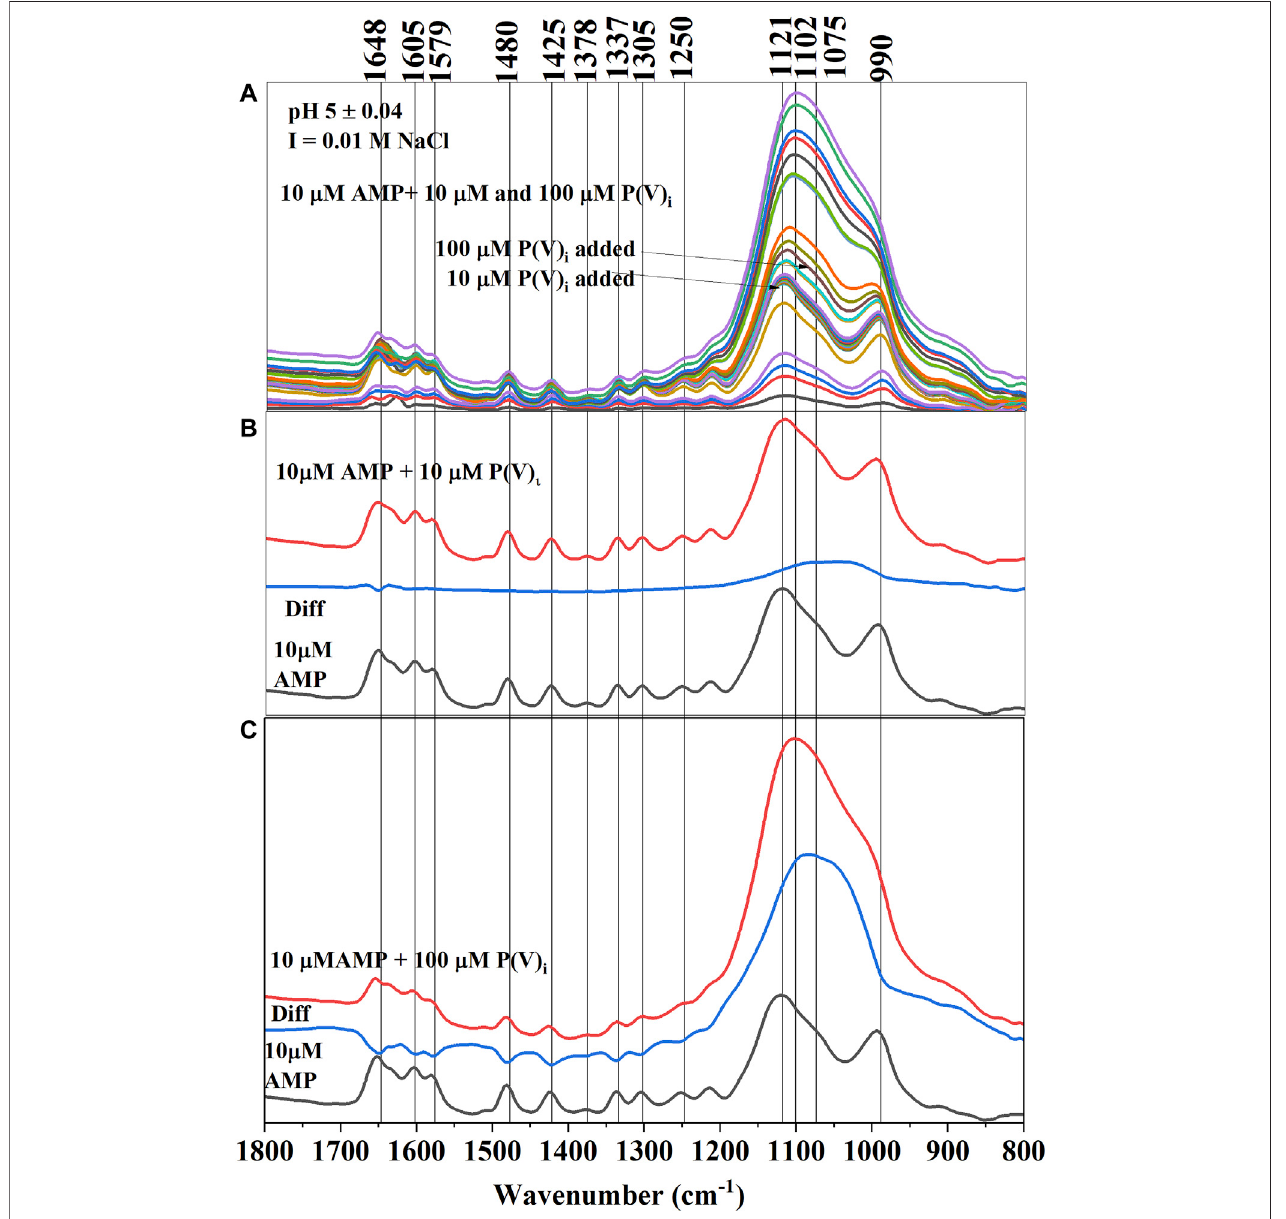
FIGURE 5 | (A) (Upper Panel) Time series in situ ATR-FTIR spectra of adsorbed AMP and inorganic phosphate (P(V) i ) at pH 5 ± 0.04. (B) (Middle Panel) Final equilibrated IR spectra of only adsorbed AMP and adsorbed (AMP+10 μ M P(V) i ) (when 10 μ M P(V) i was added) were stacked in between the difference spectrum (Diff obtainedfromsubtractingtheAMPspectrumfromtheAMP+10 μ M P(V) i spectrum). (C) (LowerPanel)FinalequilibratedIRspectraofonlyadsorbedAMPandadsorbed (AMP+100 μ M P(V) i )(when100 μ M P(V) i wasadded)werestackedinbetweenthedifferencespectrum(DiffobtainedfromsubtractingtheAMP fi nalspectrumfrom the AMP+ 100 μ M P(V) i fi nal